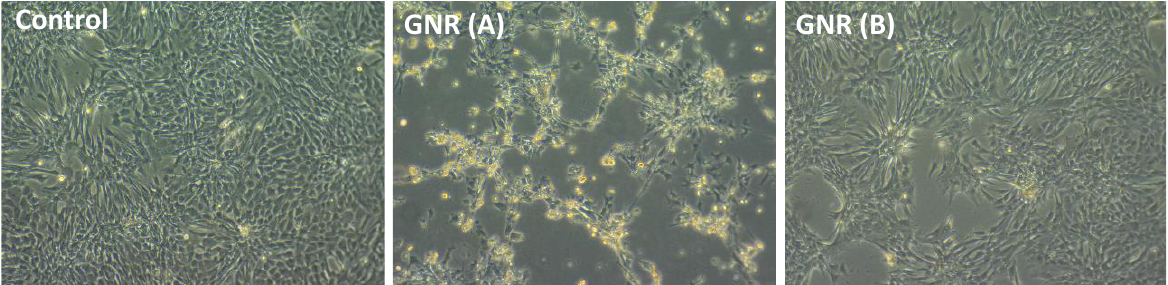
Figure 5. Effect of GNR (A) and (B) treatments on the microscopic morphology of cultured chicken embryo fibroblasts after 48 h of exposure compared to untreated cells (control). GNR (A) induced significant morphological alterations in the embryonic cells compared to GNR (B) and untreated cells.